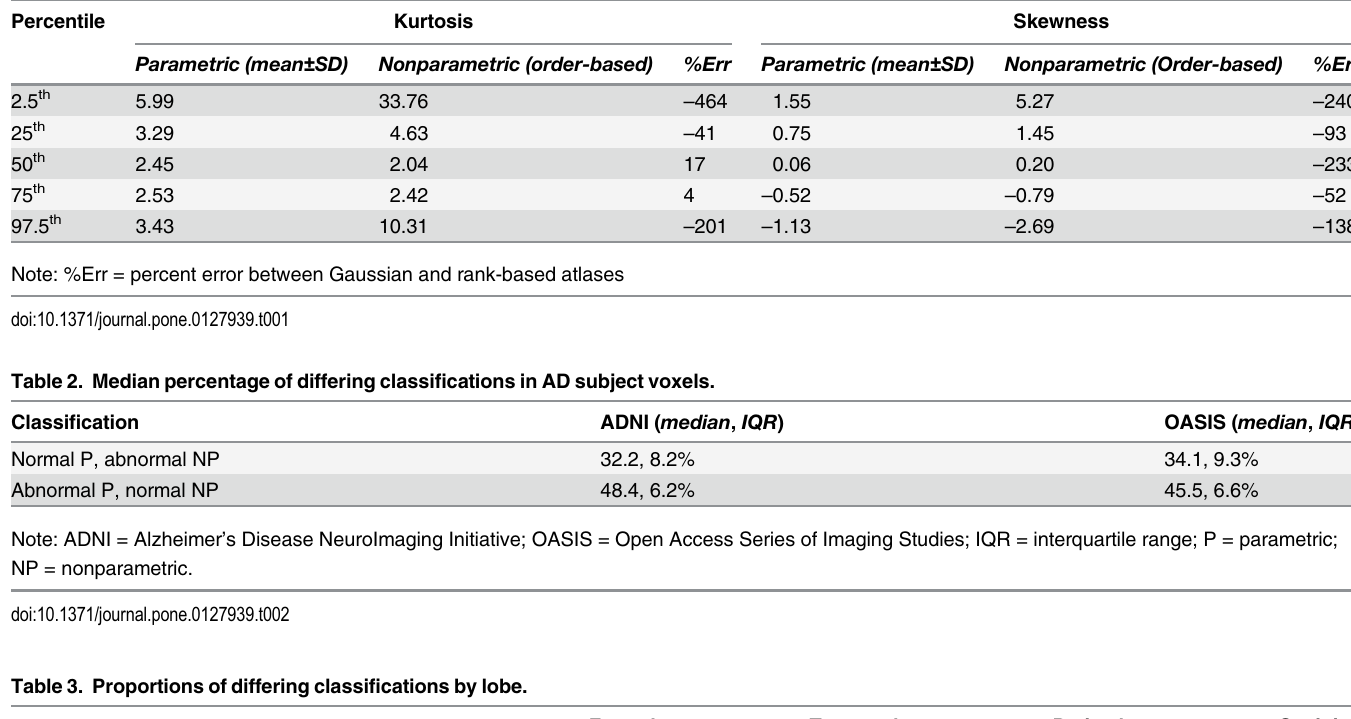
Table 1. Kurtosis and skewness in parametric and nonparametric atlas histograms of the proportion of grey matter in whole brain voxels.